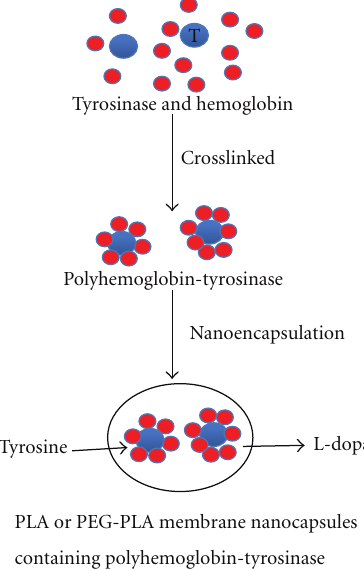
Figure 1: Schematic representation of the preparation of nano- biotechnological procedure for the PLA or PEG-PLA membrane nanocapsules containing polyhemoglobin-tyrosinase. Tyrosinase: larger blue circles. Hemoglobin: smaller red